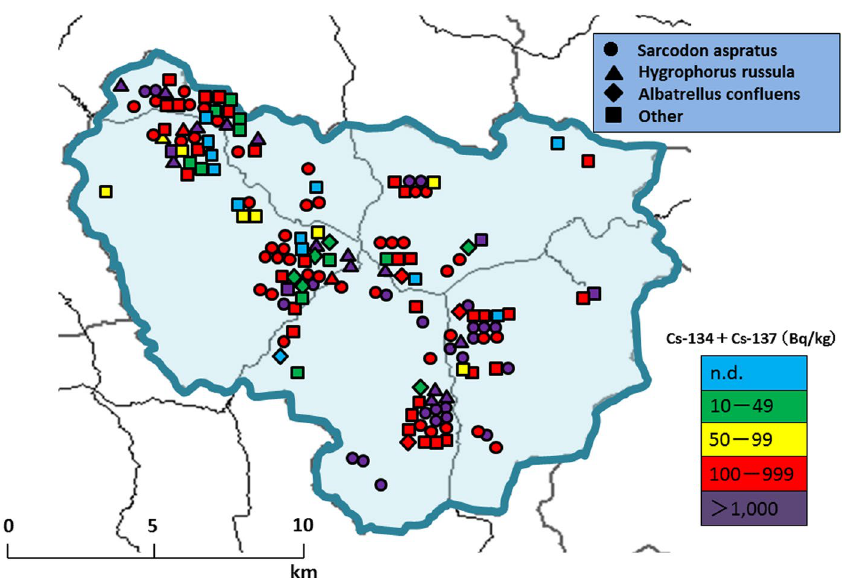
Figure 4. Sampling spots color coded by the concentration of radiocesium in mushrooms collected at each location in 2015. The bottom and top ends of the box and the bar inside the box correspond to the 25 th , 75 th , and 50 th sample percentiles, respectively. The circles with black dots represent extreme